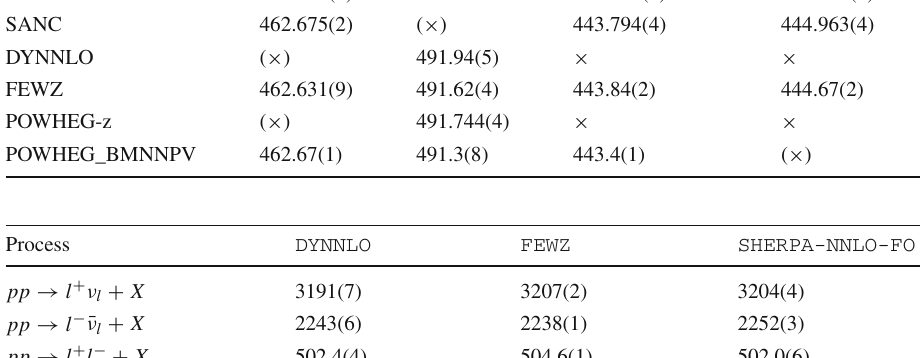
Table 11 pp → γ, Z → l − l + total cross sections (in pb) at LO, NLO EW and NLO QCD at the 8 TeV LHC with ATLAS/CMS cuts in the benchmark setup